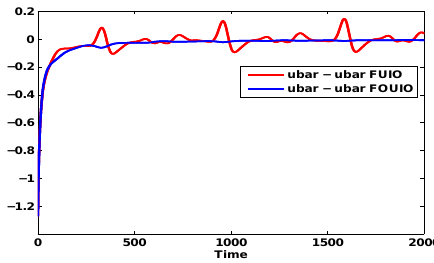
Figure 10. Unknown input errors